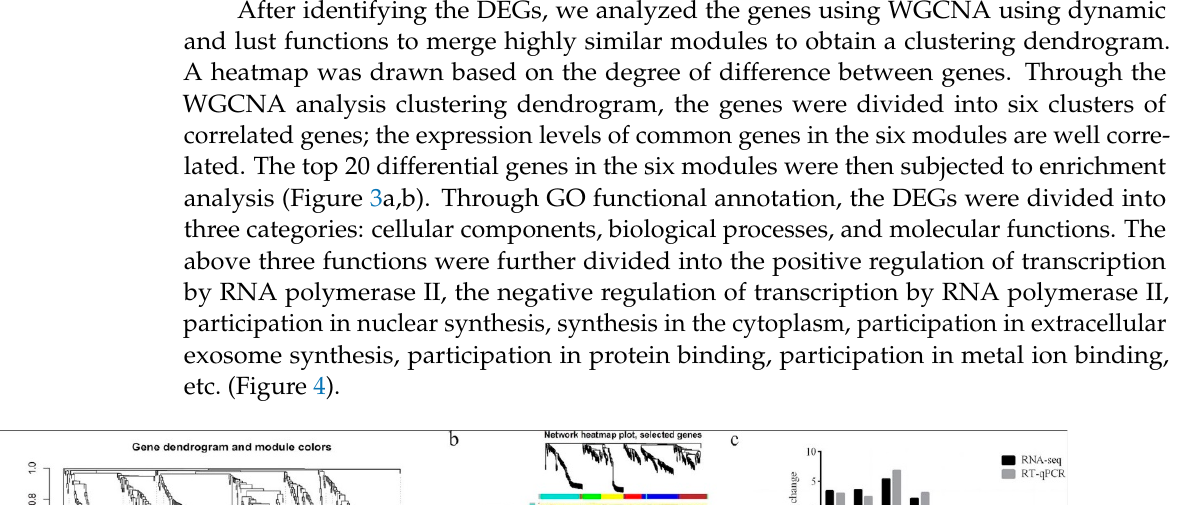
Figure 2. Volcano plot of DEGs among the study comparison groups. ( a ) Volcano plot of DEGs in BvsA. ( b ) Volcano plot of DEGs in CvsB. ( c ) Volcano plot of DEGs in DvsB. A: control group; B: treadmill group; C: acupoint catgut embedding group 1; D: acupoint catgut embedding group 2; DEGs: differentially expressed genes.